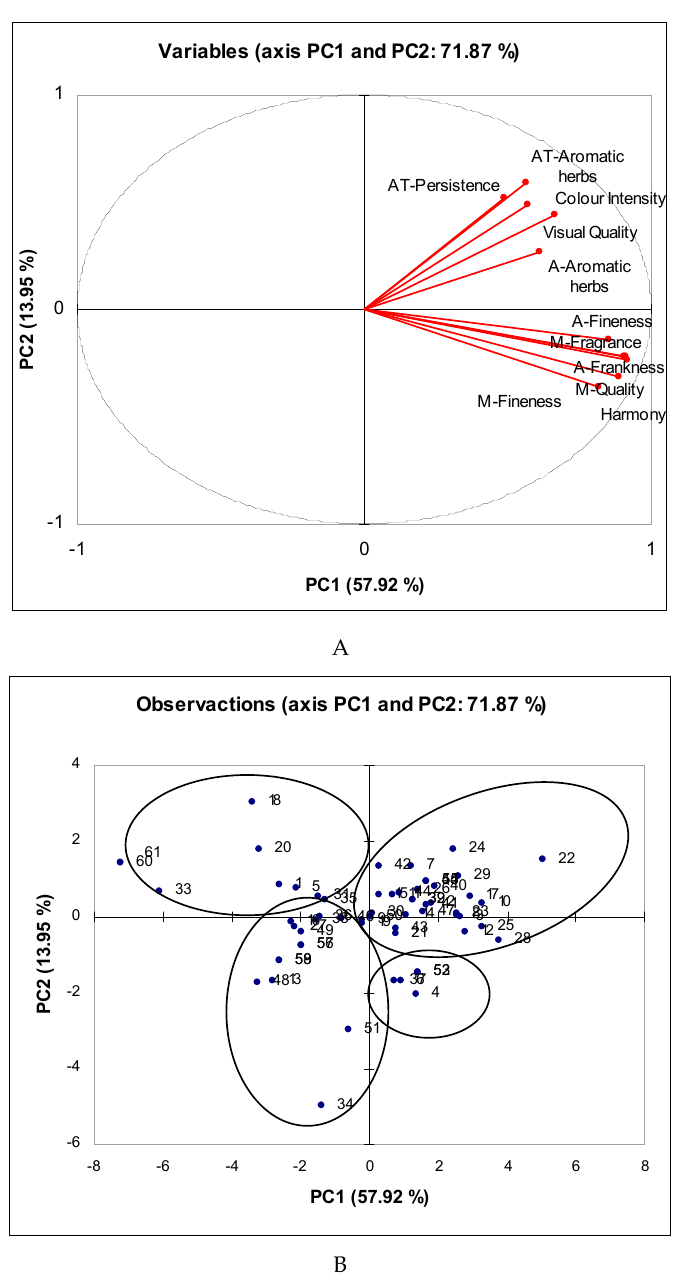
Figure 2. Component analysis score plot of ( A ) sensory descriptors and ( B ) samples (213 herbal liqueurs). A: aroma; AT: aftertaste; M: Mouth.